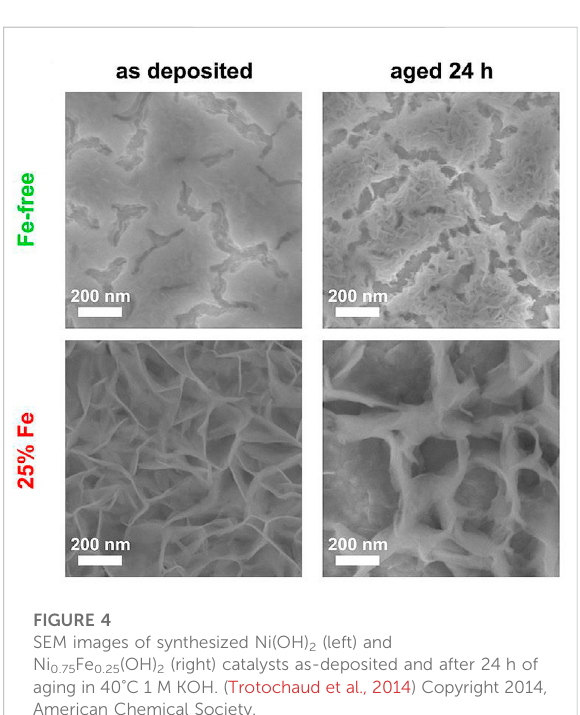
FIGURE 4 SEM images of synthesized Ni(OH) 2 (left) and Ni 0.75 Fe 0.25 (OH) 2 (right) catalysts as-deposited and after 24 h of aging in 40 ° C 1 M KOH. (Trotochaud et al., 2014) Copyright 2014, American Chemical